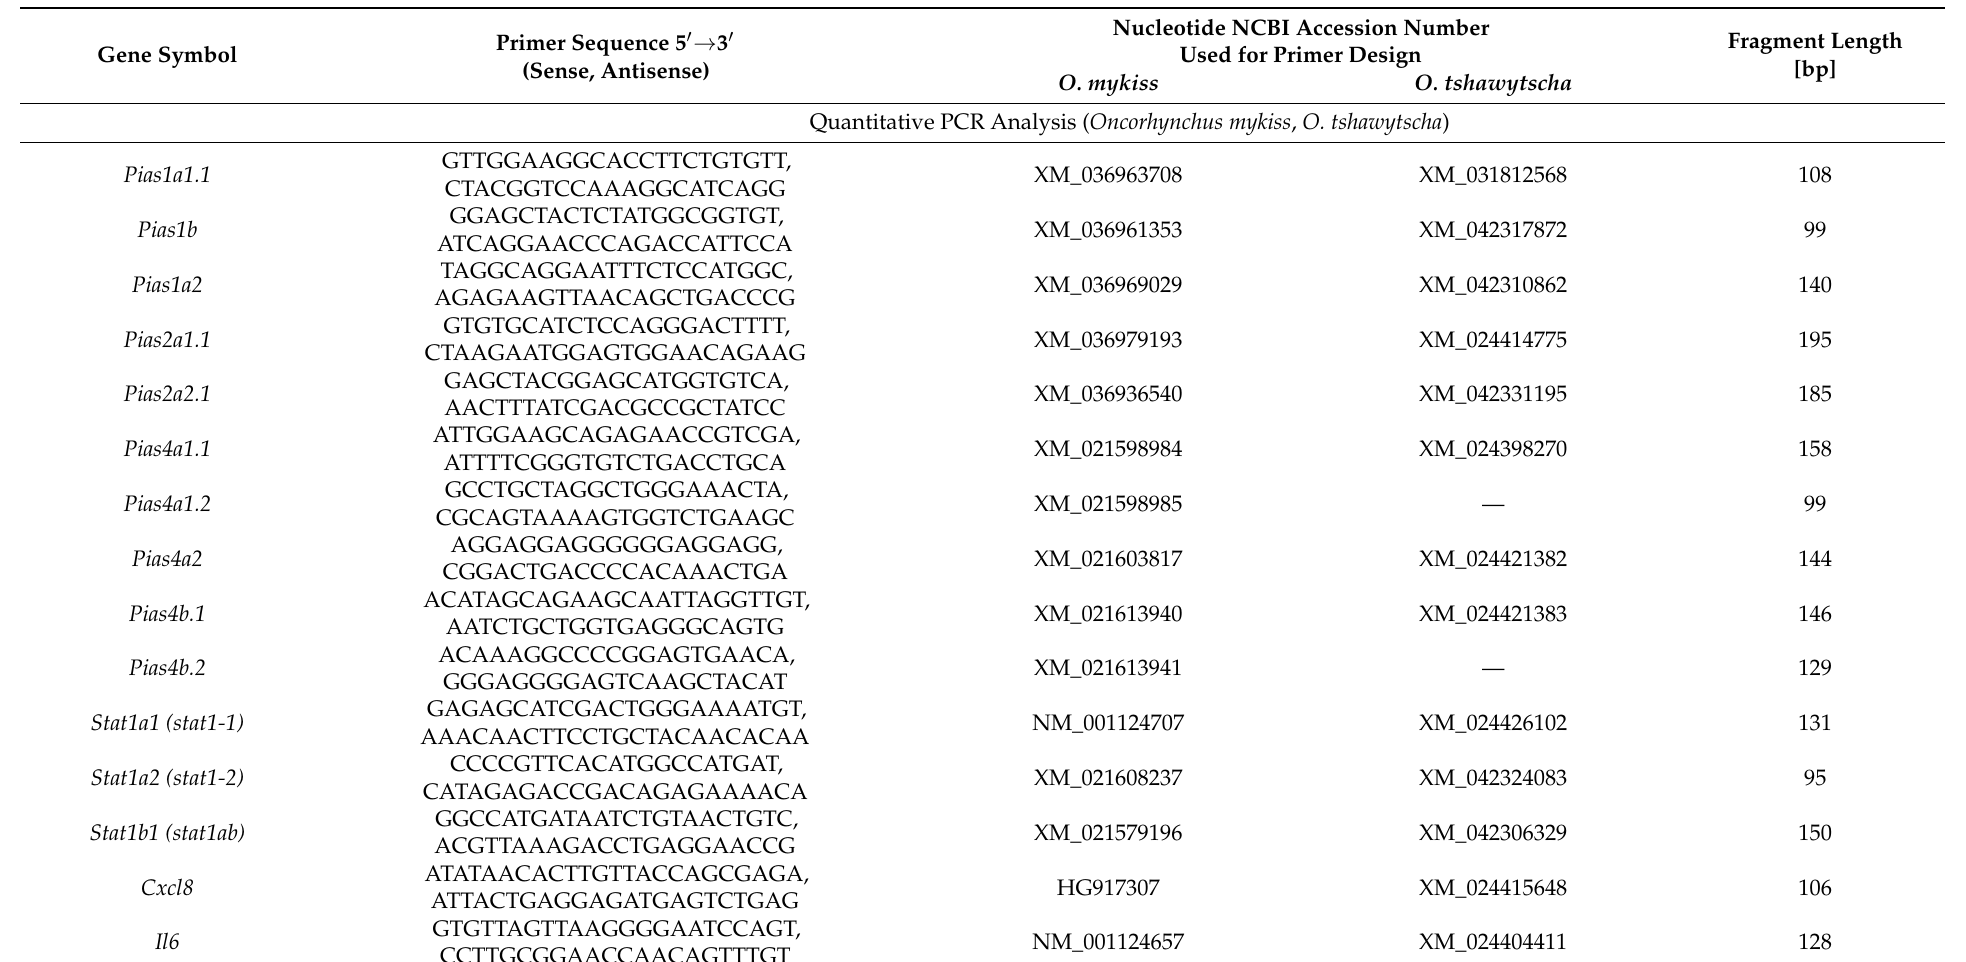
Table 2. Primers used in this